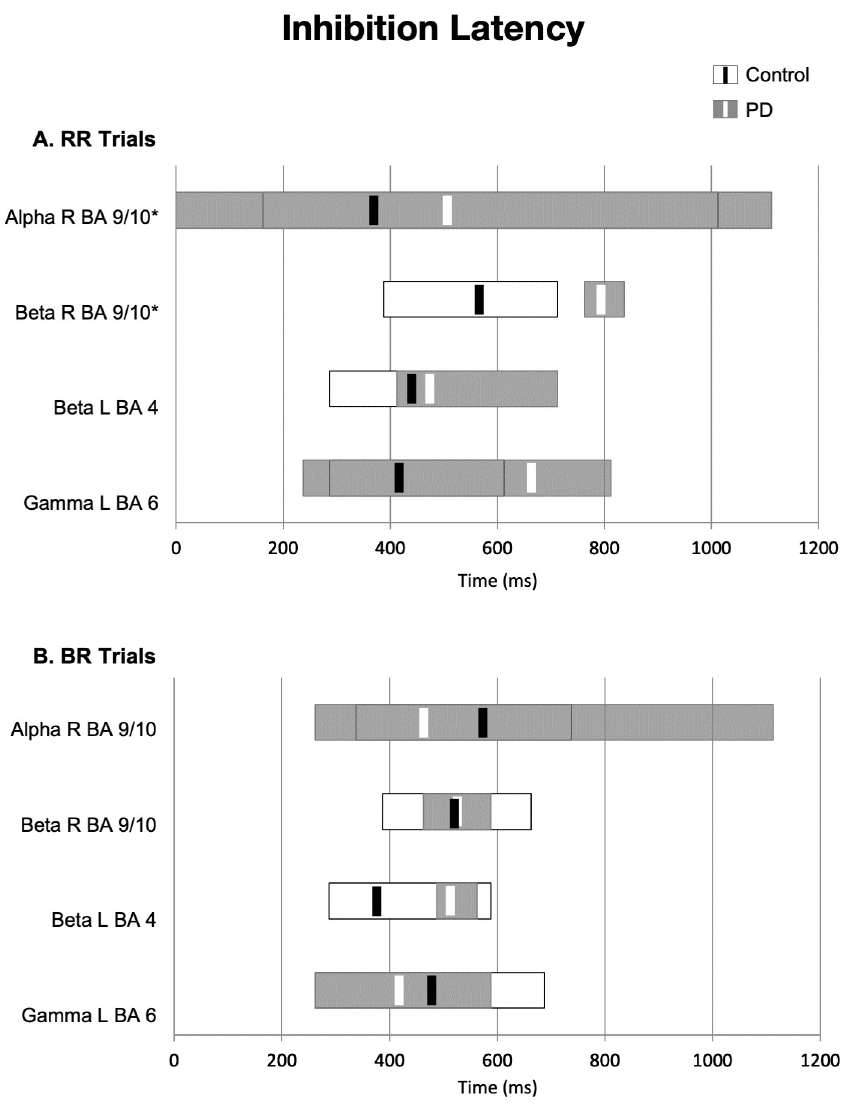
Fig 5. Inhibition latency. (A) Onset and duration (gray and white bars) of power change in each ROI for the matched control trials. Latency of peak intensity is indicated by solid black or white lines. (B) Onset and duration of power change in each ROI for the mismatched inhibition condition. Peak latency was significantly longer in the PD vs. control group: � p <